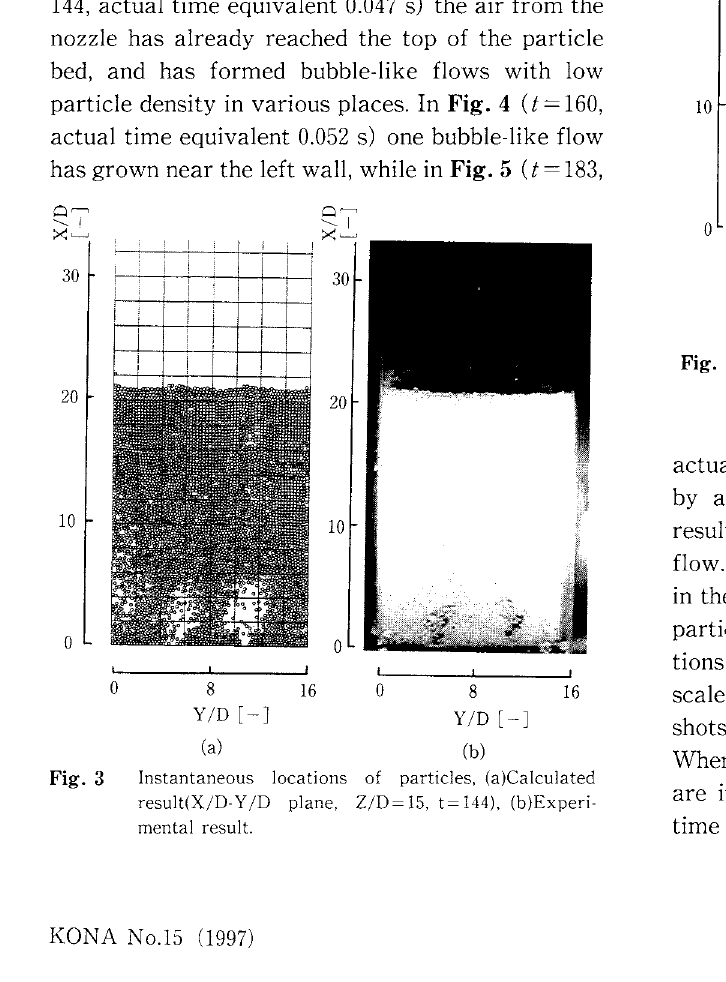
Fig. 4 Instantaneous locations of particles, (a)Calculated result(X/D-Y /D plane, Z/D= 15, t= 160), (b)Experimen tal result.